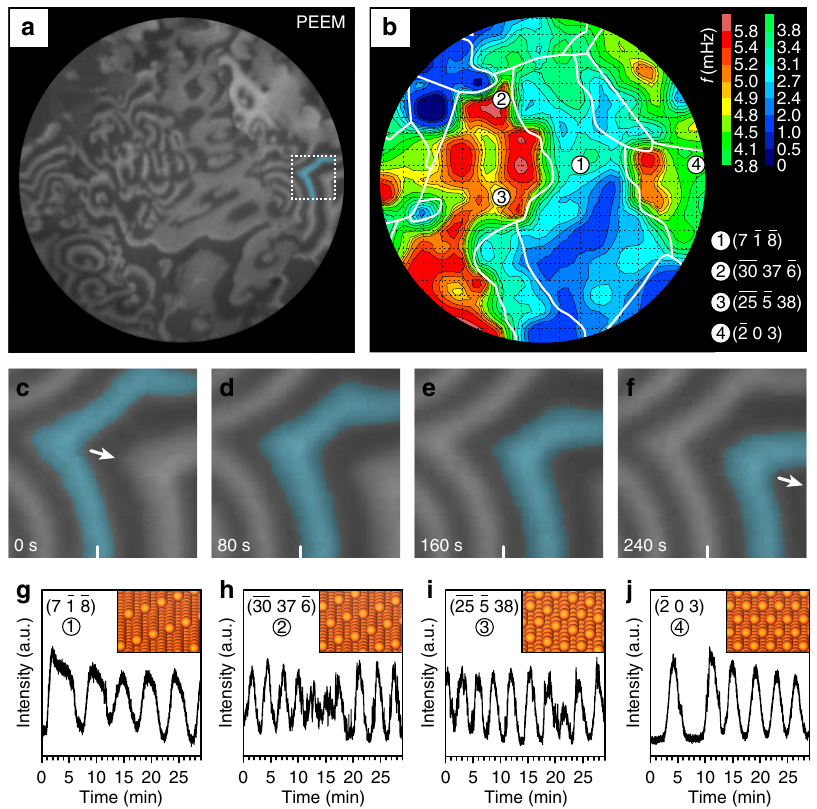
Fig. 1 Isothermal kinetic oscillations in H 2 oxidation on polycrystalline Rh on a µ m scale. ( a ) PEEM snapshot ( fi eld of view 520 µ m) taken during H 2 oxidation at constant p O2 = 1.1 × 10 − 6 mbar, p H2 = 8.4 × 10 − 7 mbar, and T = 433 K; ( b ) “ frequency map ” of the observed oscillations. Crystallographically different domains are marked with white lines (see also Supplementary Note 1). The numbered circular symbols mark the selected crystallographic orientations; ( c - f ) propagation of a chemical wave in the 70 × 70 µ m 2 section marked in ( a ); ( g – j ) time-dependent (oscillating) local PEEM intensities of selected regions. The positions of the corresponding circular ROIs (of 1 µ m diameter) are placed in the centers of the circular symbols in ( b ). The ball model insets illustrate the stepped surface structure of the selected regions, the Miller indices of which were determined by EBSD measurements